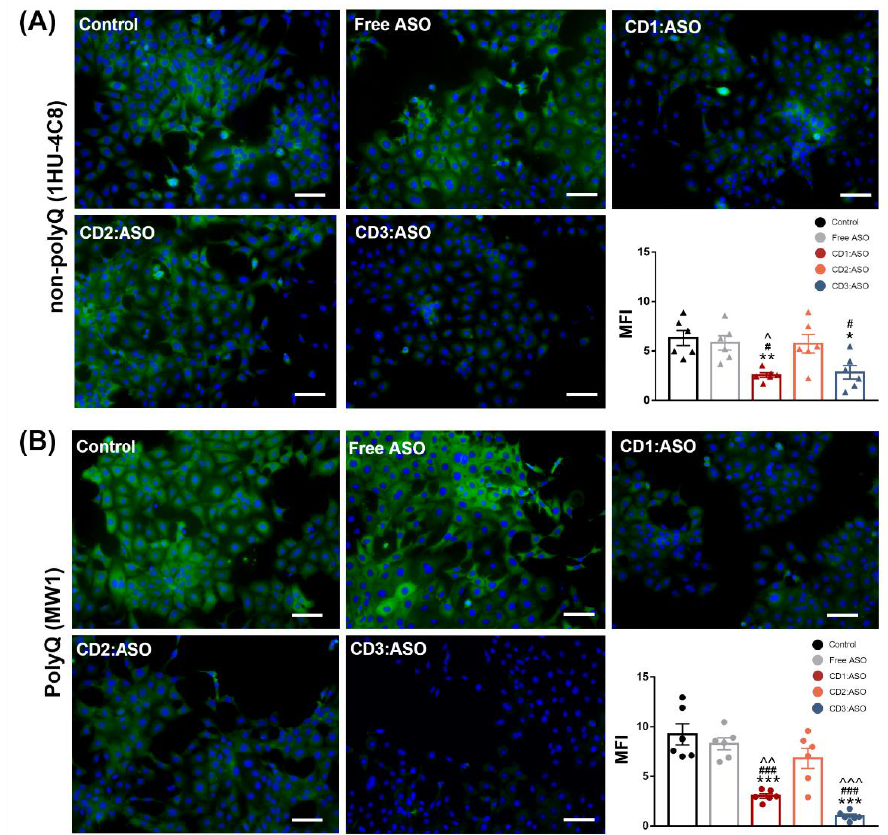
Figure 5. The expression levels of mutant and total HTT after transfection with ASO alone or complexed with cyclodextrins . ST14A cells were treated with ASO (100 nM per well) for 72 h. After this period, the cells were fixed and stained with polyQ (mutant) antibody MABN2427 (clone MW1) and non-polyQ antibody MAB2166 (clone 1HU-4C8). Representative confocal images of ( A ) non-polyQ antibody and ( B ) polyQ antibody after treatment with ASO alone or complexed with CDs. Both antibodies were stained with Alexa 488 (green), while the nucleus was stained with DAPI (blue). Quantification of the mean fluorescence intensity (MFI) of confocal images (n = 1 – 2 per group from three independent experiments). Data are reported as mean ± SEM, * p < 0.05, ** p < 0.01, and *** p < 0.001 compared to control; # p < 0.05, and ### p < 0.001 compared to Free ASO; ^ p < 0.05, ^^ p < 0.01, and ^^^ p < 0.001 compared to CD2:ASO. One- way ANOVA was followed by Tukey’s post hoc test . Scale bars = 50 µm.